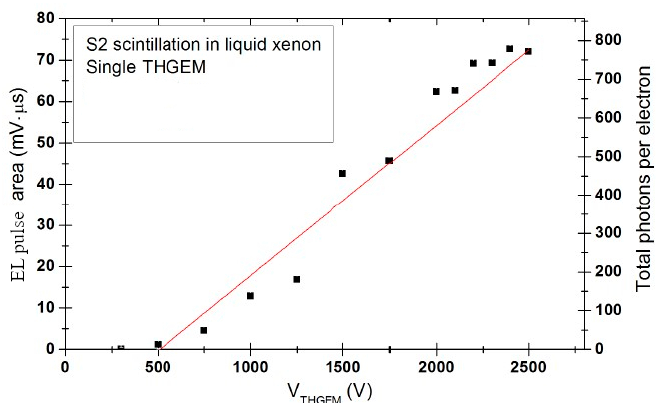
Figure 29. Amplitude of proportional EL signal (pulse-area) and its EL yield (number of photons per drifting electron) produced by THGEM in liquid Xe as a function of the THGEM voltage [83].